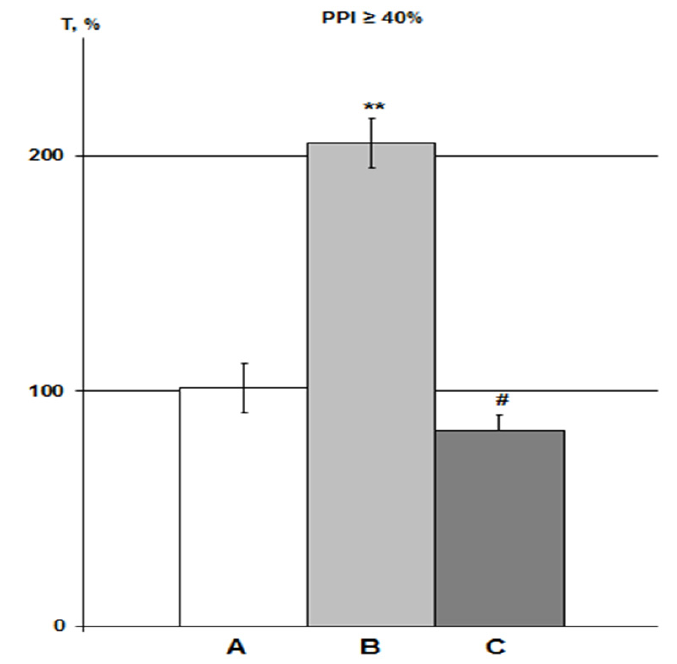
Figure 5. Effect of PNU on DMSO action on HBH efficiency with iHippo administration. The T values are expressed as in Figure 3 (means ± SEM%). A, control group (n = 11); B, DMSO iHippo group (n = 8) as ‘C’ in Figure 4; C, PNU iHippo group (n = 6). On the graph, PNU at a concentration of 30 µ M completely cancels the potentiating effect of DMSO on HBH efficiency and reduces the preconditioning effect of HBH by 18%, but this decrease is not significant. * significant differences with the control group; # significant differences with the DMSO iHippo group. ** p < 0.02; # p < 0.03. The Wilcoxon–Mann–Whitney test (u-criterion) and Fisher’s exact test (FET-criterion). p values are presented as amended by the Holm–Bonferroni method. Table 1. Correlation analysis between the variational series of DMSO and control groups. Correlation between the T values of control group with the combined DMSO group (NN 1–2), DMSO IP group (NN 1–3), and DMSO iHippo group (NN 1–4). See Section 2.2.2 for details. Pearson’s r-criterion. p values are presented as amended by the Holm-Bonferroni method. NN Injection